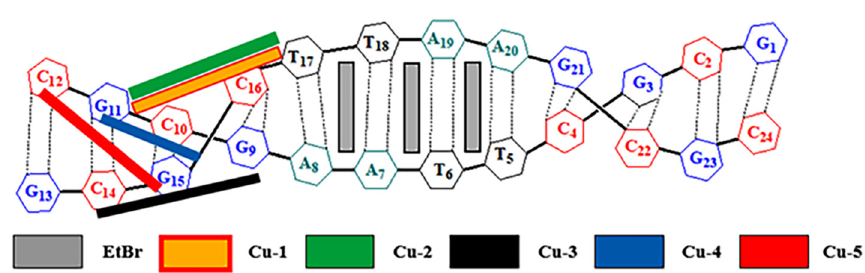
Figure 8. Cartoon illustration of the possible binding sites of the Cu-compounds as estimated by molecular docking modeling.